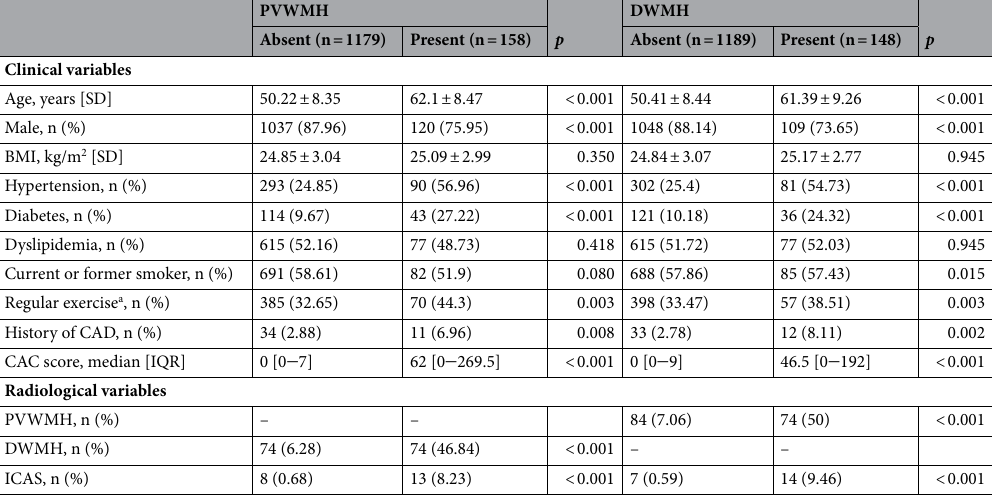
Table 2. Baseline characteristics of the groups with or without PVWMH and DWMH. PVWMH Periventricular white matter hyperintensity, DWMH Deep white matter hyperintensity, BMI Body mass index, LDL Low-density lipoprotein, HDL High-density lipoprotein, HbA1c Glycohemoglobin, CAD Coronary artery disease, CAC Coronary artery calcium, ICAS Intracranial artery stenosis, SD Standard deviation, IQR Interquartile range. a Regular engagement in vigorous exercise for more than 10 min at least 3 times per